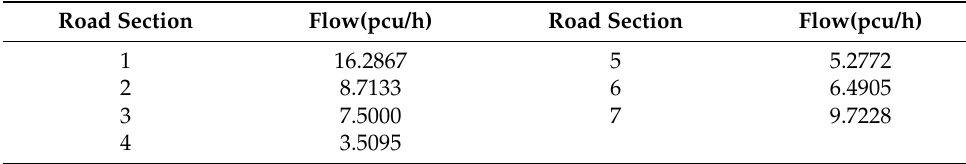
Table 4. Equilibrium solution of state 7.